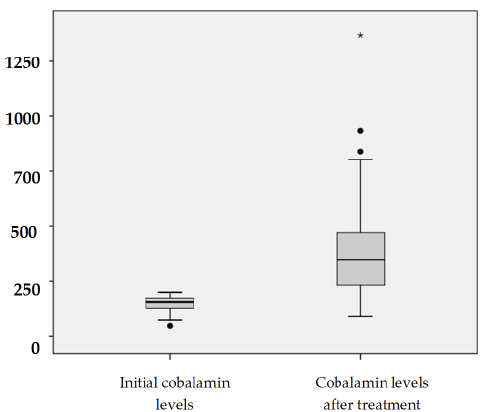
Figure 1. Serum cobalamin levels (pg/mL) before and after treatment with oral cyanocobalamin. * Extreme value (1369 pg/mL).